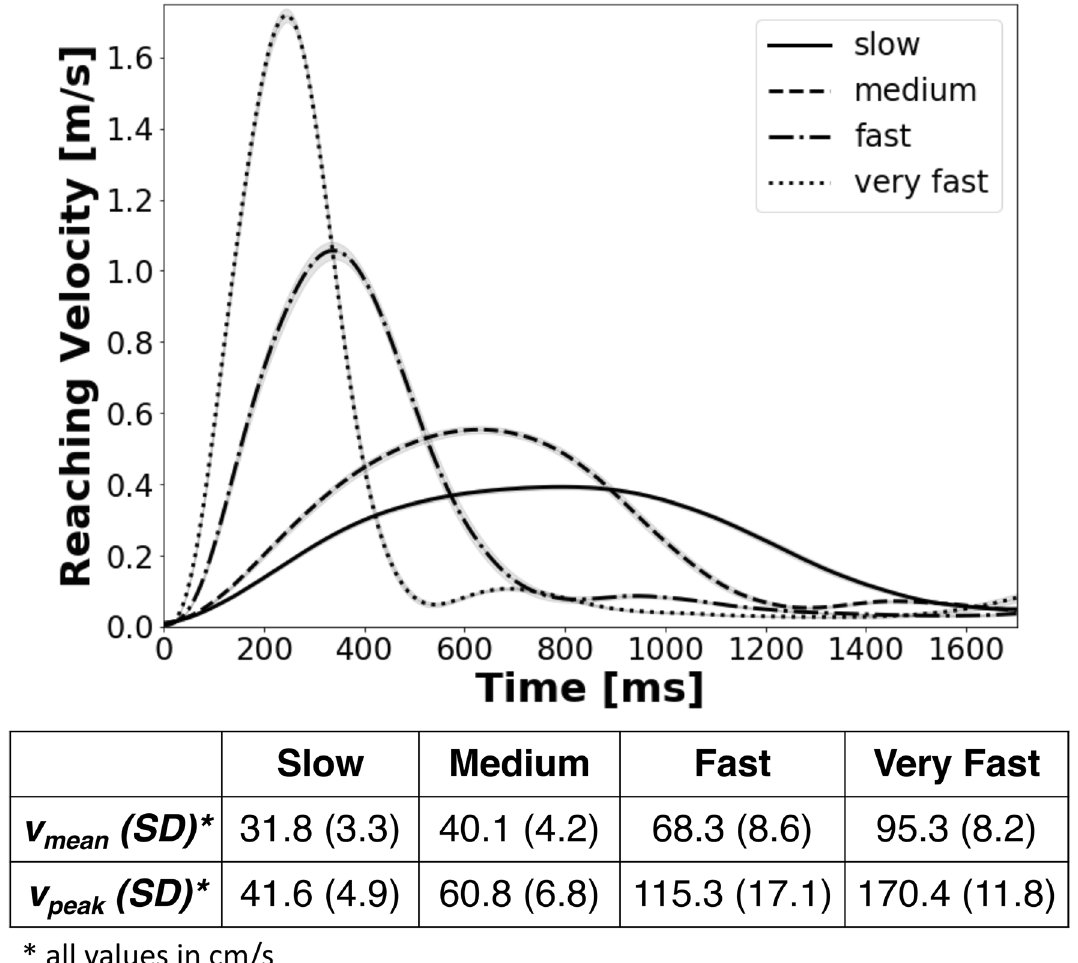
Figure 1. Velocity profiles of the receiver’s reaching velocity. Confidence bands were generated using a point- by-point bootstrap approach by Joch et al. 16 . The table includes measured mean and peak velocities for all four velocity